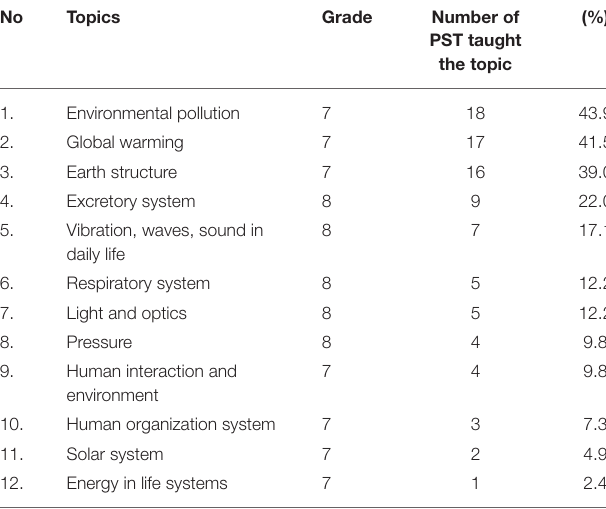
TABLE 1 | The topics taught by the pre-service science teacher.